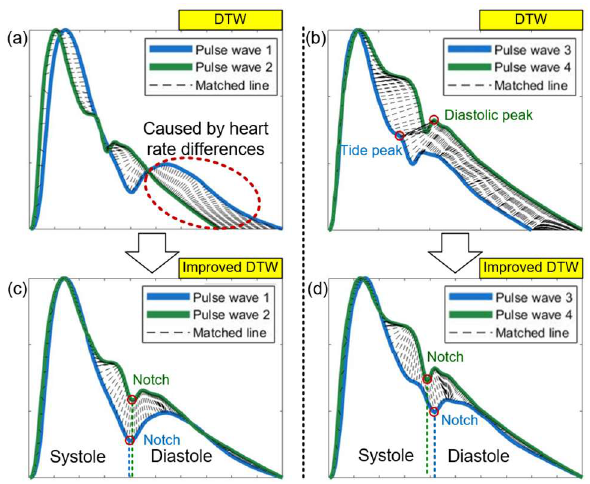
Figure 7. Matched points between two pulse waveforms using DTW ( a , b ) and improved DTW ( c , d ).